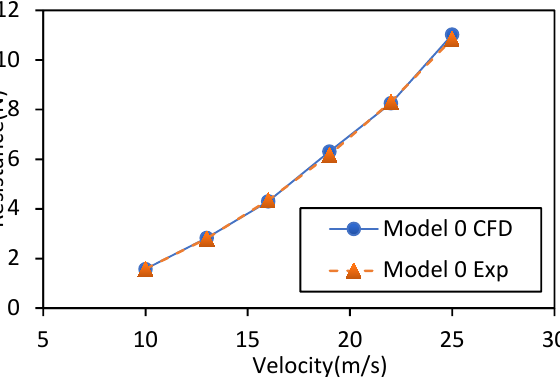
Table 4. Comparison of experimental data and simulation